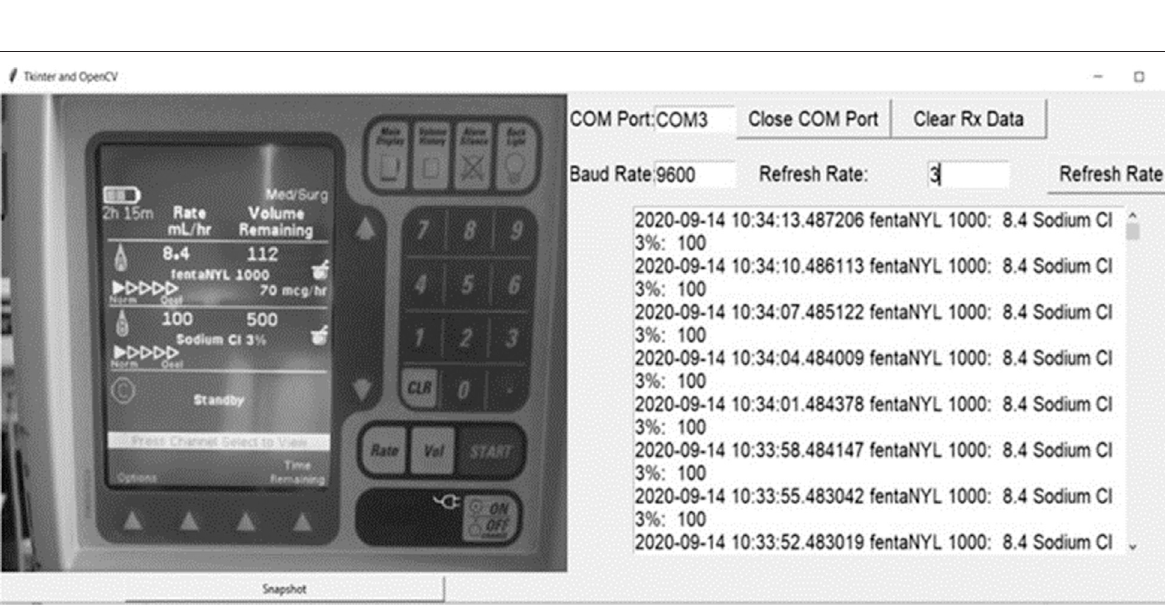
Frontiers in Big Data |